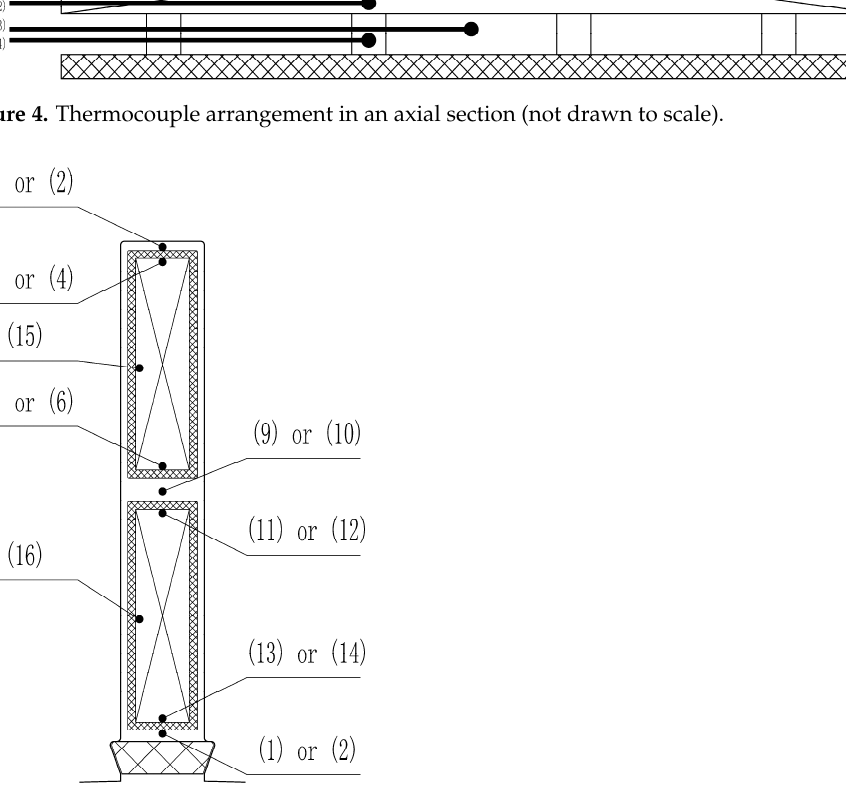
Figure 4. Thermocouple arrangement in an axial section (not drawn to scale).